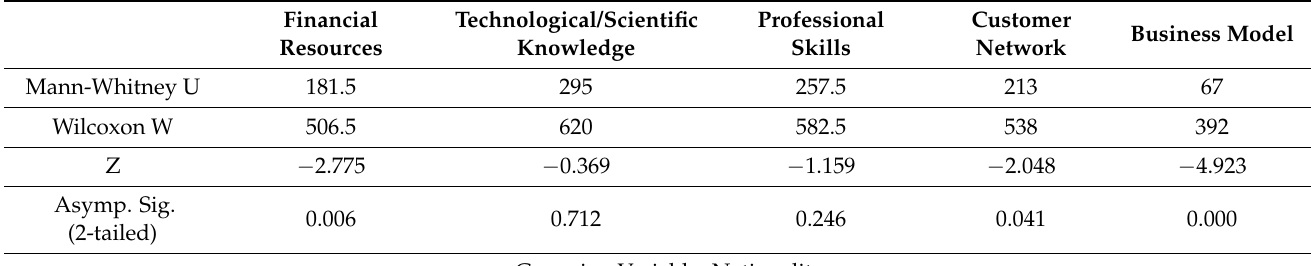
Table 6. Mann Whitney test statistics for key criteria contributing to business development.